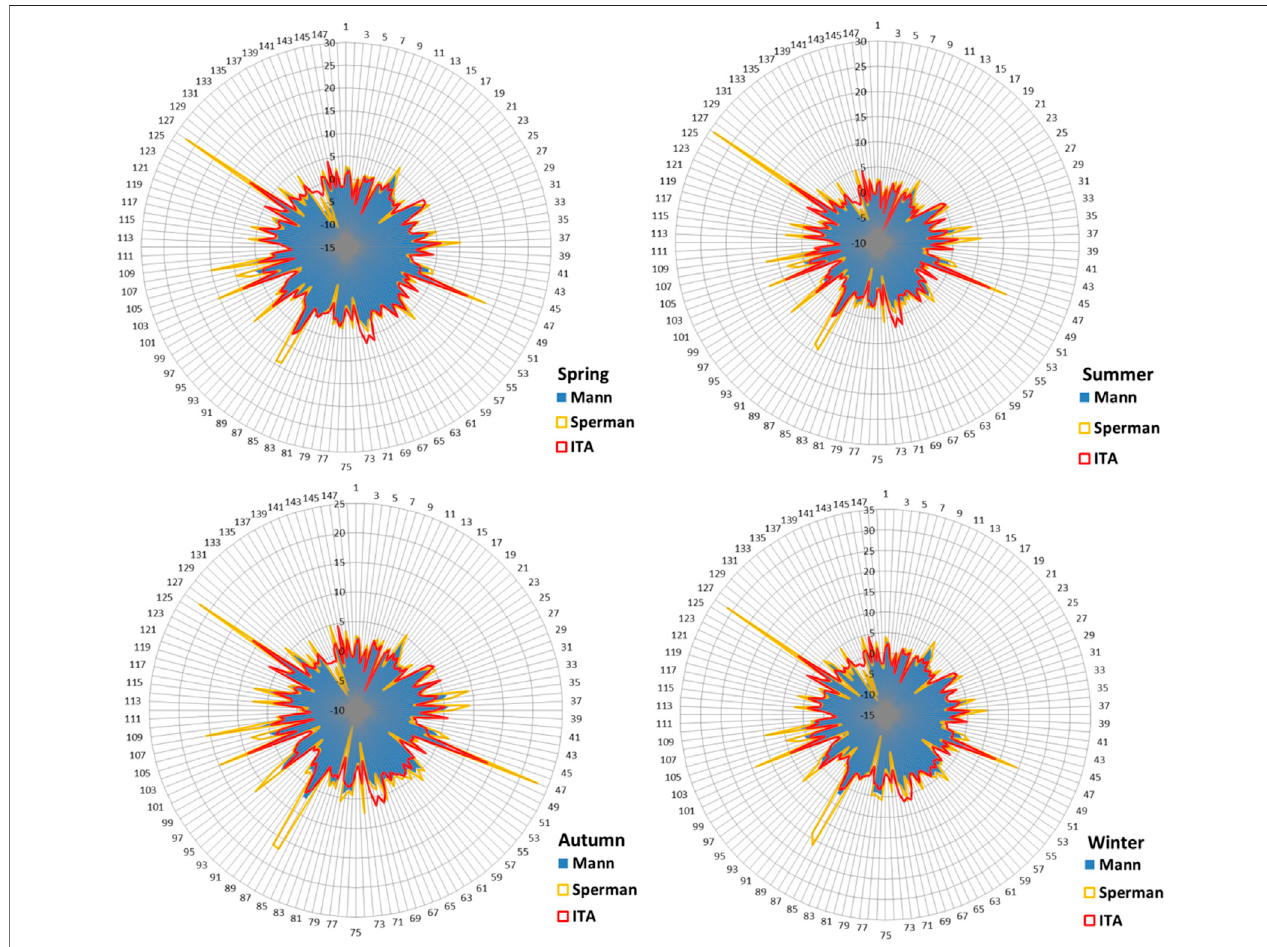
FIGURE 5 | Comparison between seasonal trends values obtained by MK, SR and ITA